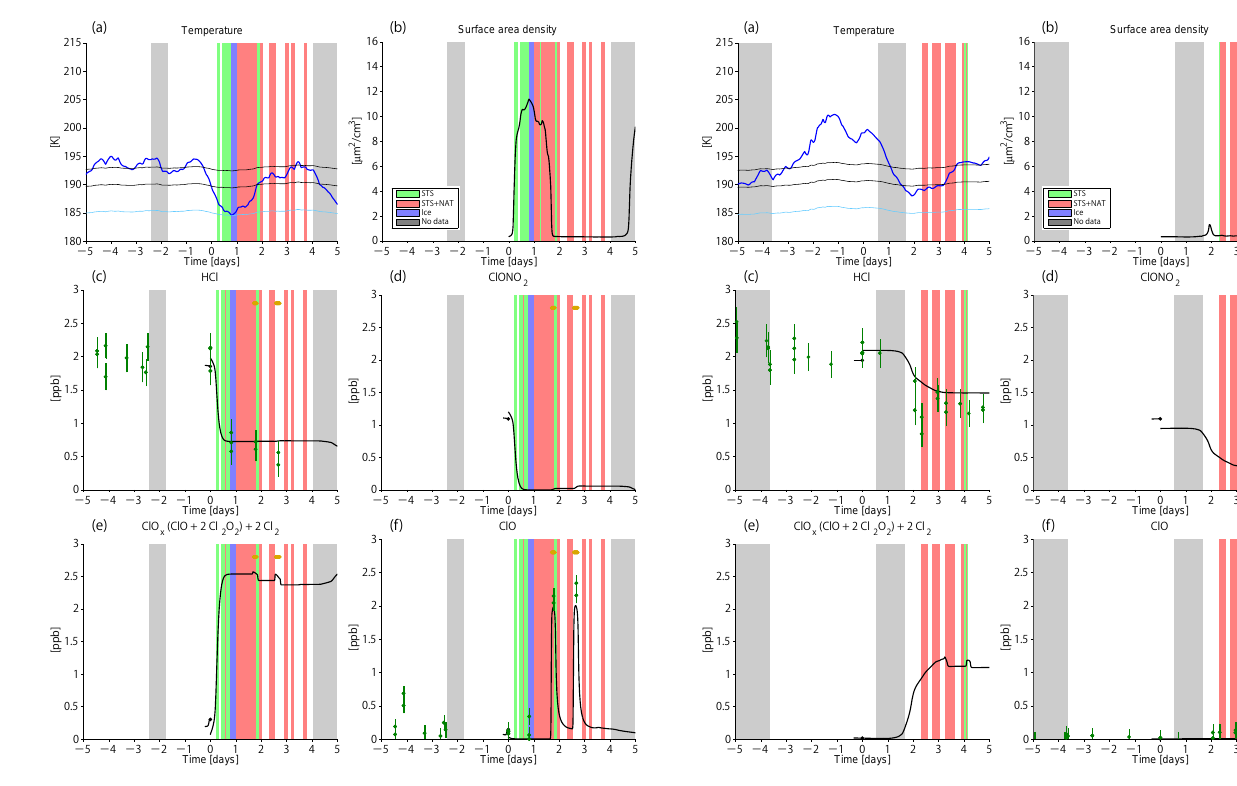
Figure 10. Same as Fig. 8 but for trajectory case no. 08, starting at 16:59:14UT on 31 December 2009 at an altitude of 24.05km.